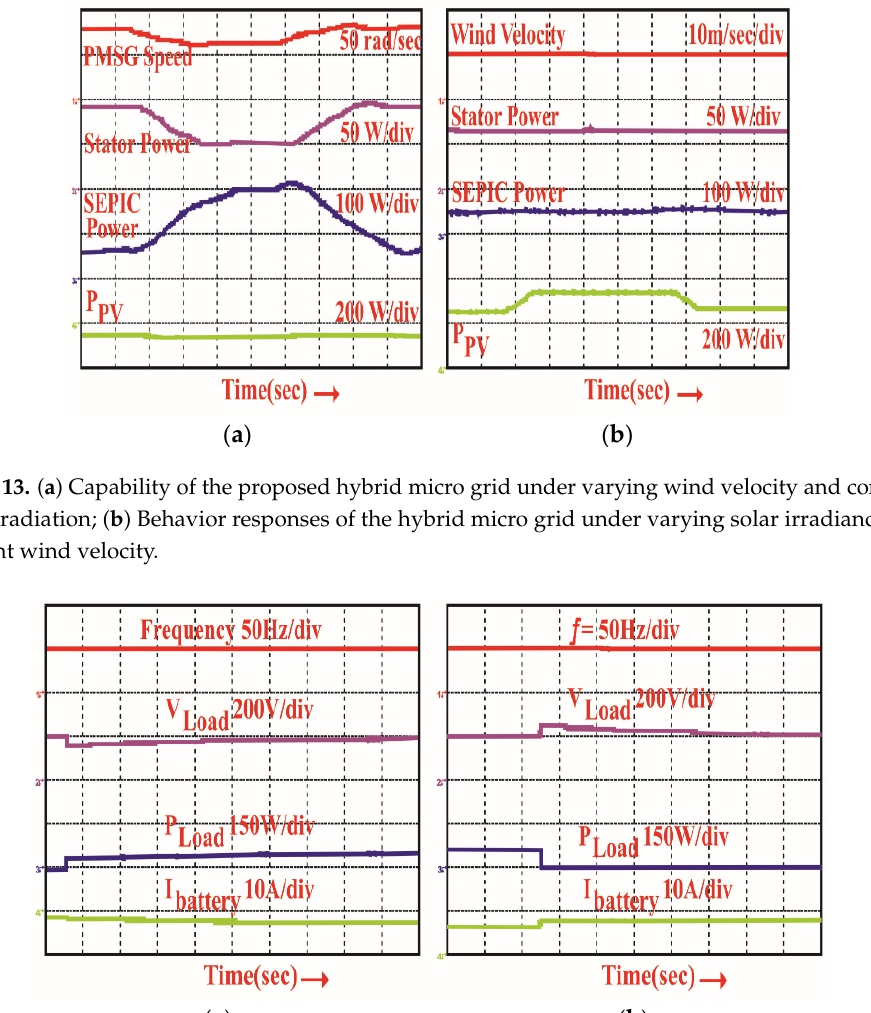
Figure 15. The performance of the wind generator is evaluated under disconnecting operating conditions to the micro grid.